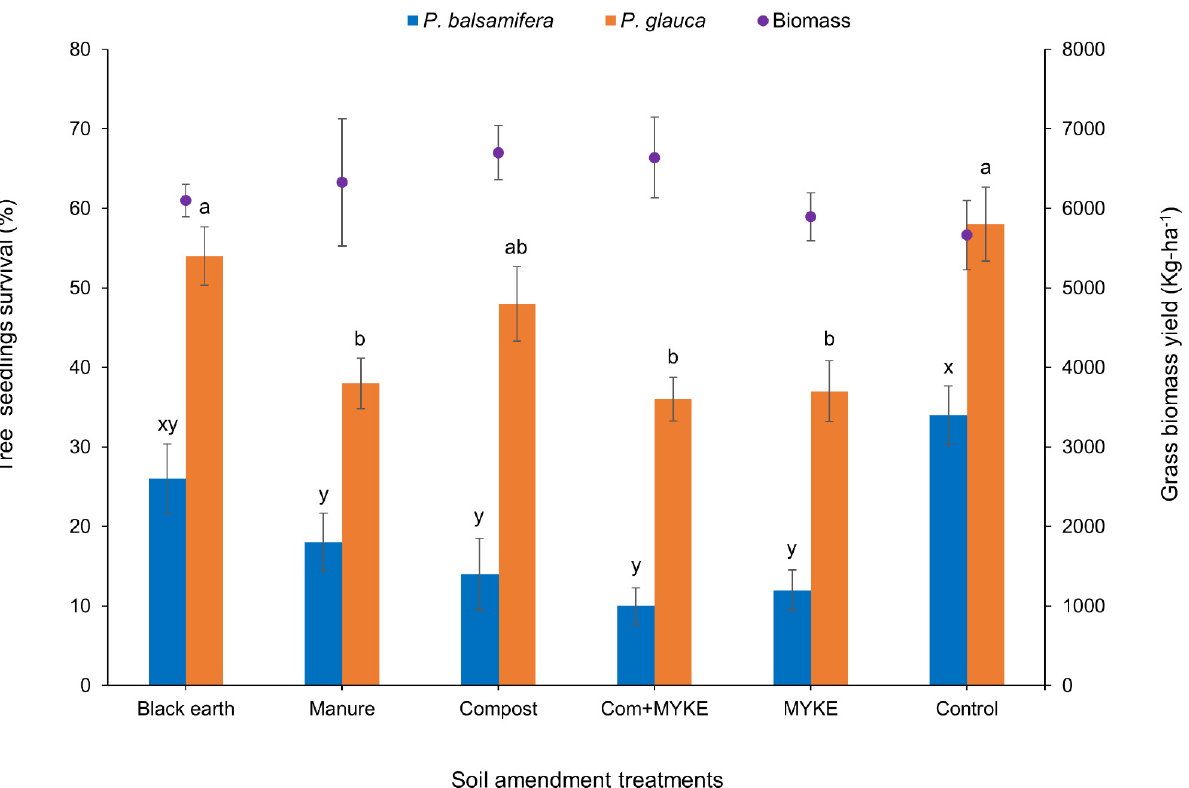
Figure 5. Mean (±) percent tree survival of P. balsamifera and P. glauca by amendment treatment including mean (±) grass yield shown with dots. Different letters indicate significant differences at p = 0.05 in pairwise Z-tests.